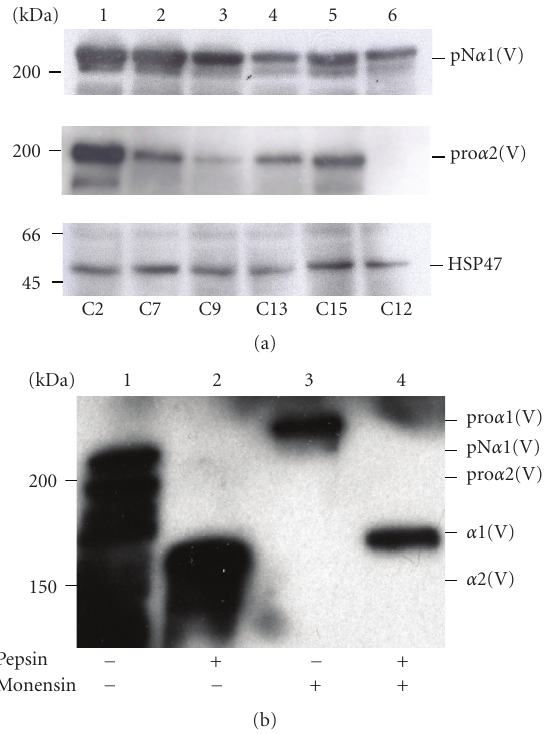
Figure 6: (a) Selection of clones expressing pro α 1(V), pro α 2(V) chains and HSP47. Western blot analysis of transfected cell media (for pro α 1(V) and pro α 2(V) chain detection) or cell lysates (for HSP47 detection) probed with (first panel) 6A7 monoclonal antibody, which recognizes the N-propeptide of the human pro α 1(V) chain, (second panel) with collagen type V (G-15) antibodies, which recognize the human pro α 2(V) chain, (third panel) with antibody to HSP47. Of twenty-one clones, only five clones expressed the three partners with di ff erent expression levels: C2 (lane 1), C7 (lane 2), C9 (lane3), C13 (lane 4), and C15 (lane 5). The other clones expressed only two of the three partners. For example, clone C12 (lane 6) expressed only the pro α 1(V) chain and HSP47. (b) Western blot analysis of media from clone C2 treated with (lanes 3, 4) or without monensin (lanes 1, 2) using polyclonal collagen V antibodies. Media were incubated with (lanes 2, 4) or without pepsin (lanes 1, 3). Left, molecular mass standards expressed in